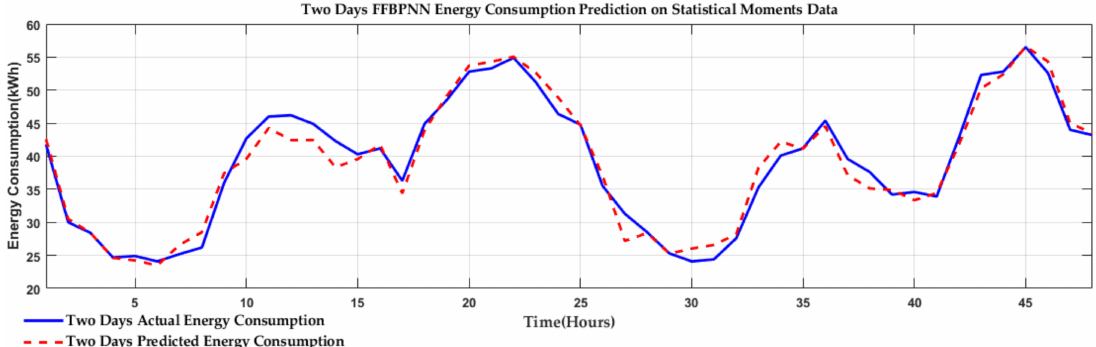
Figure 18. Two days hourly energy consumption prediction using FFBPNN on statistical moments data.